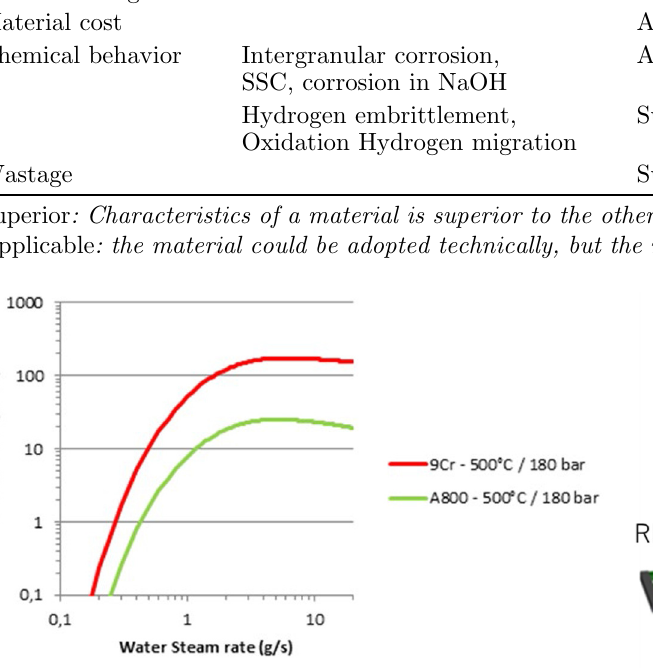
Fig. 5. Comparison of the wastage rates between 9Cr and A800 alloys.